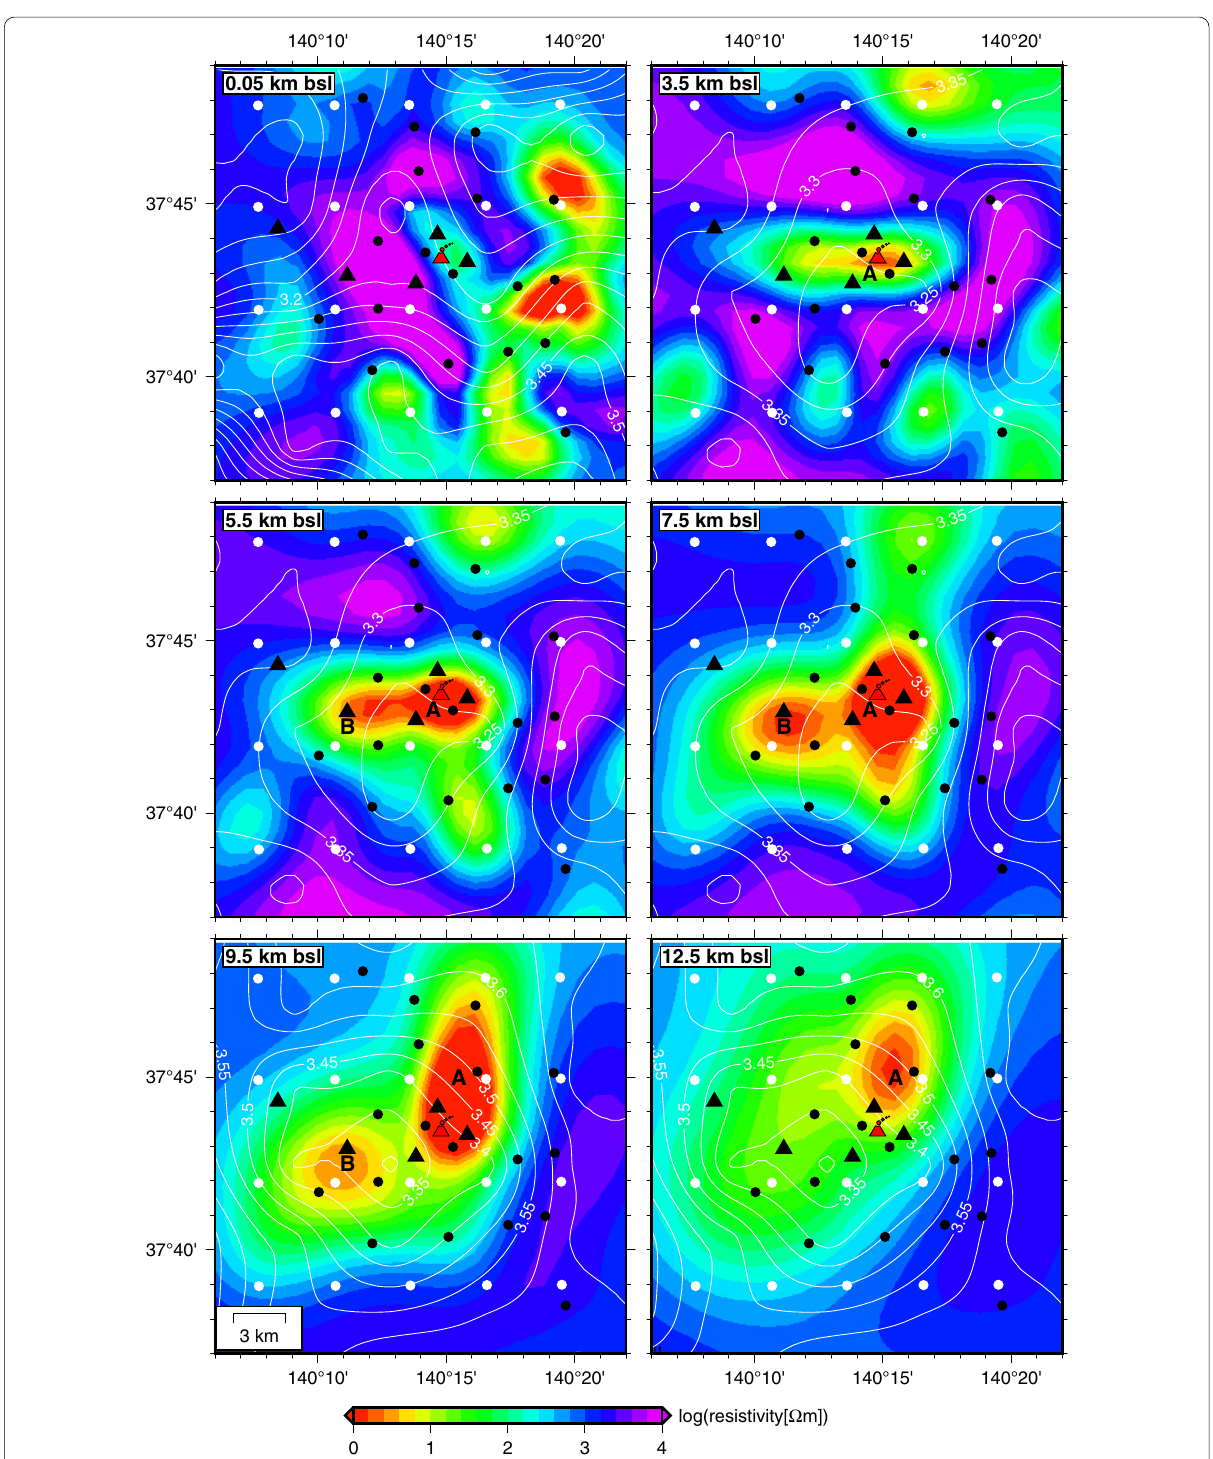
Fig. 15 Plan or map view of the V s model by Okada et al. (2015) superimposed on the resistivity model (Fig. 5). The white lines are V s contours with the interval of 0.05 km/s. The background color represents the logarithmic resistivity value. The black and white circles, red character, and black triangles, are observation sites, sampling point of V s model, Oana Crater, and edifice summits, respectively. The labels A and B for the conductors are referred to in “Results”